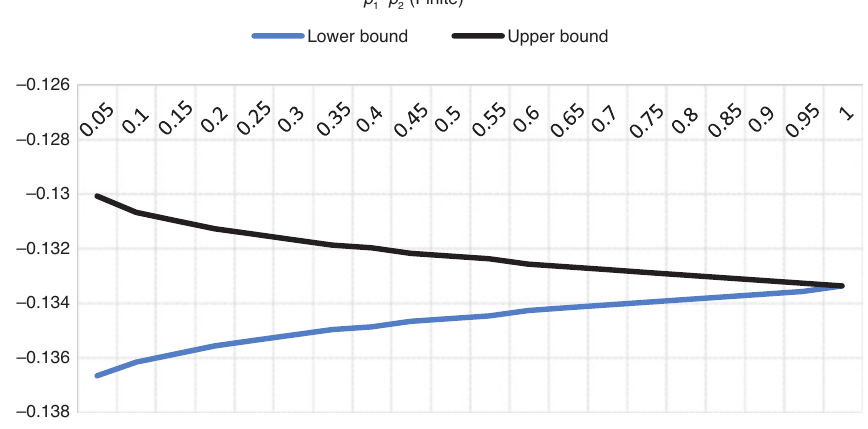
Figure 3: Confidence Intervals of Differences in Finite Population